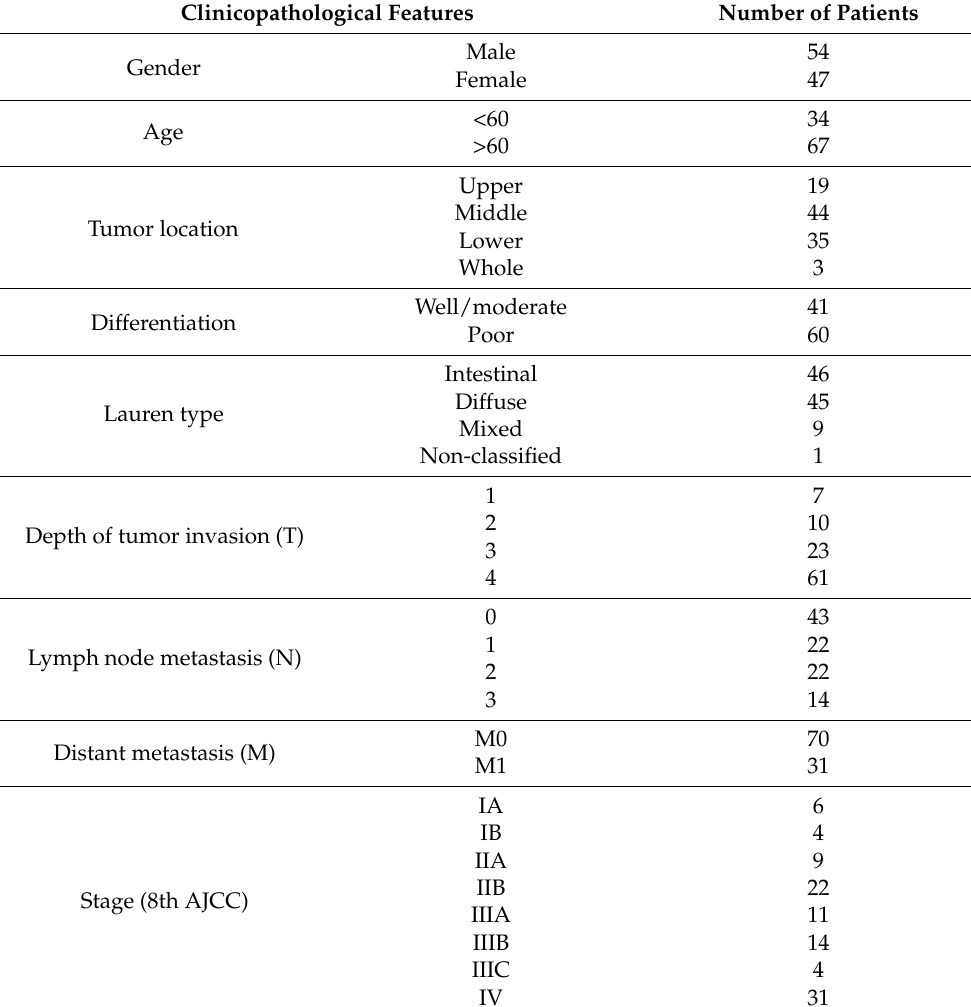
Table 7. Patient